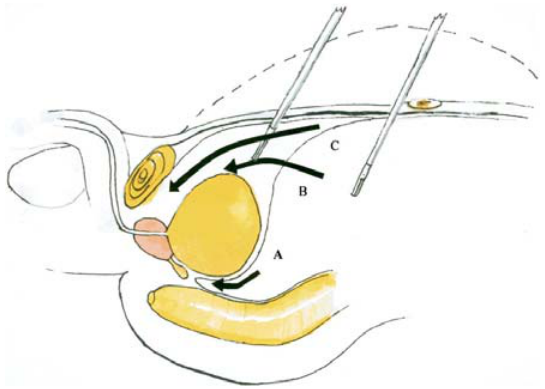
FIGURE 2. Initial surgical approaches to LRP. A: Montsouris technique. B: Heilbronn, Vattikuti Institute, University of California Irvine technique. (Note: Heilbronn uses an ascending prostatic dissection, whereas Vattikutti Institute and University of California Irvine use a descending dissection). C: Extraperitoneal technique. (Figure reprinted from Surgical Endoscopy 18(12), 1694–1711, 2004.